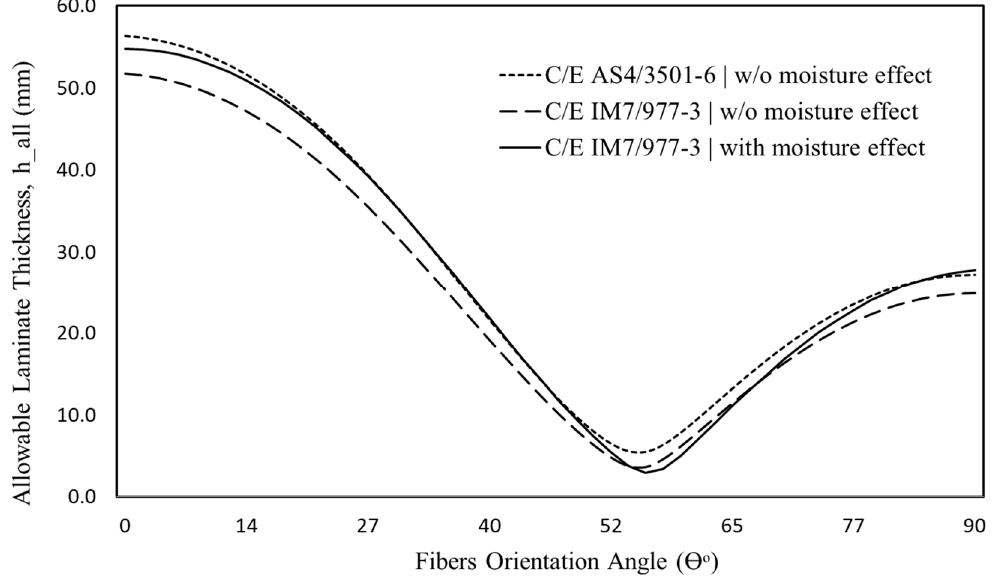
Figure 8. Variation of vessel thickness with fibers orientation angle for case 1, 2 and 3. The lay-up is (± θ )ns and the PV size is 406.6 mm in diameter and 1000 mm in length.